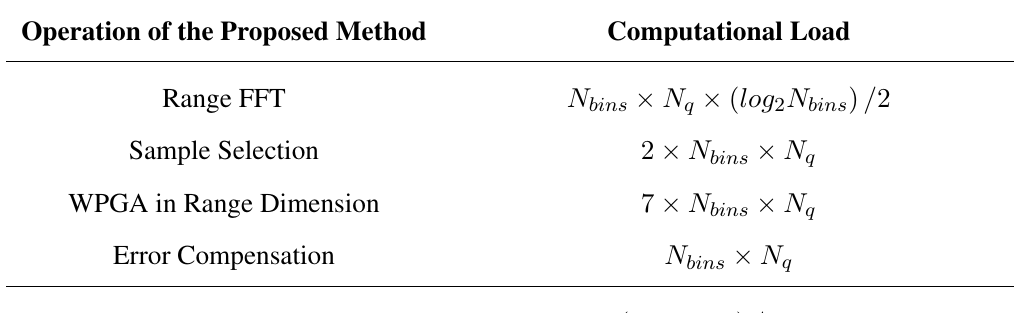
Table 4. Computational complexity of the proposed